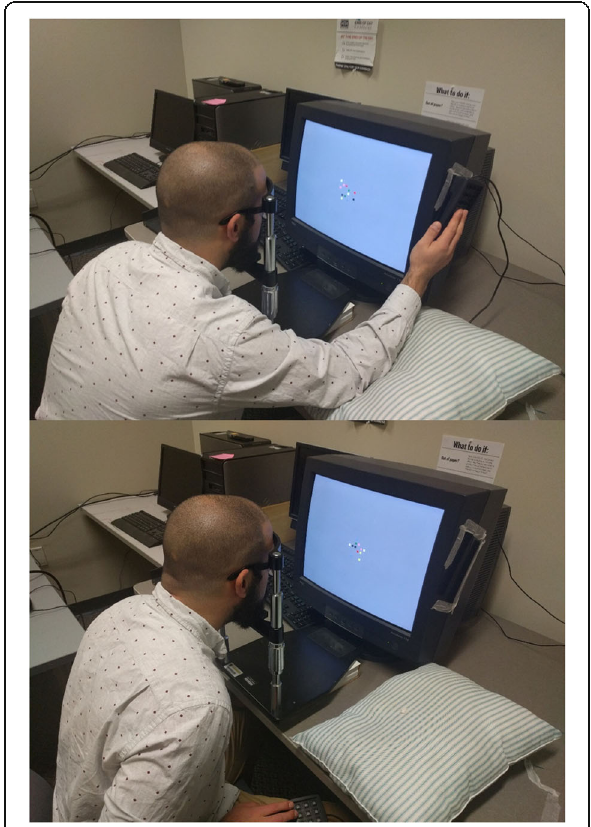
Fig. 4 Depiction of the experimental setup and hand positions